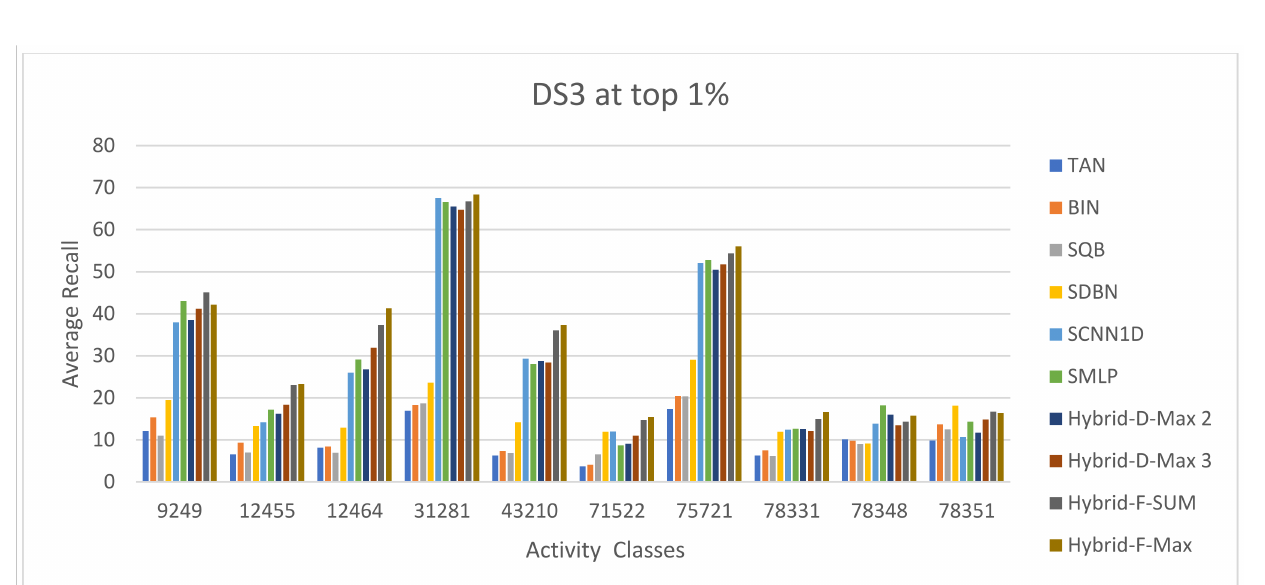
Figure 12. The comparison among methods for the average recall percentage at the top 1% in MDDR-DS3 (structurally